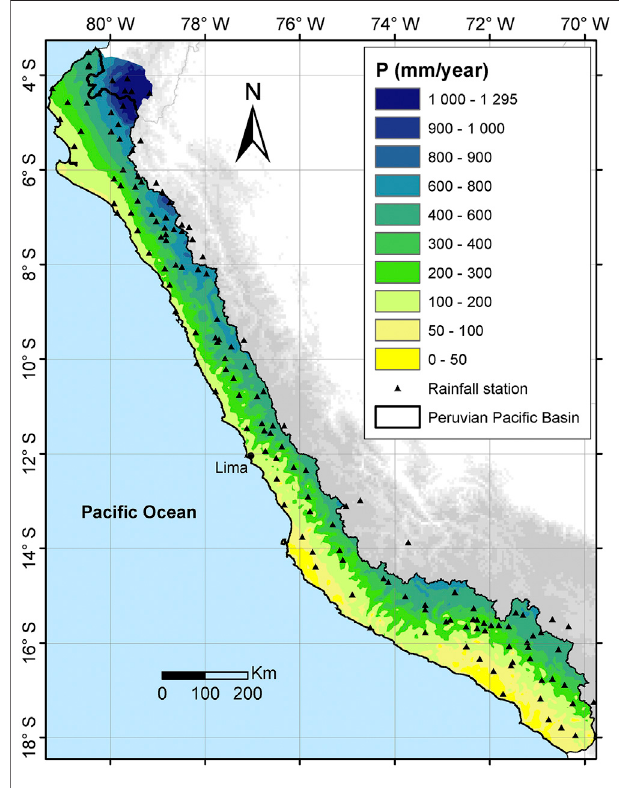
FIGURE 4 | Mean annual rainfall in the Paci fi c coast of Peru (1964 – 2011). Adapted from Rau et al. (2016).